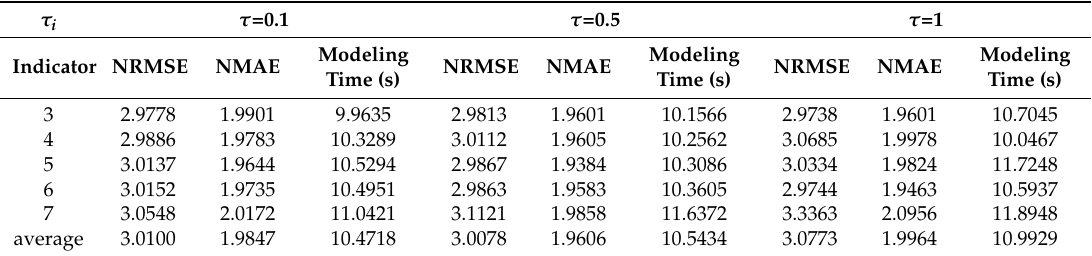
Table 1. The NRMSE and NMAE of the testing sample with different values of m and τ .